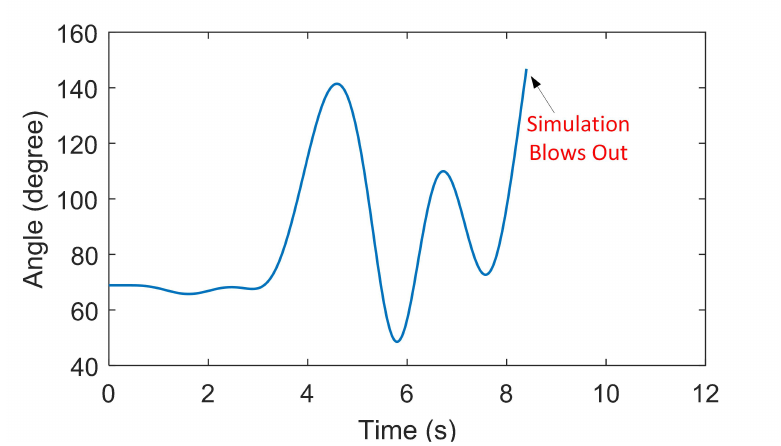
Figure 13. Machine 5–10 Machine angle differences for a severe